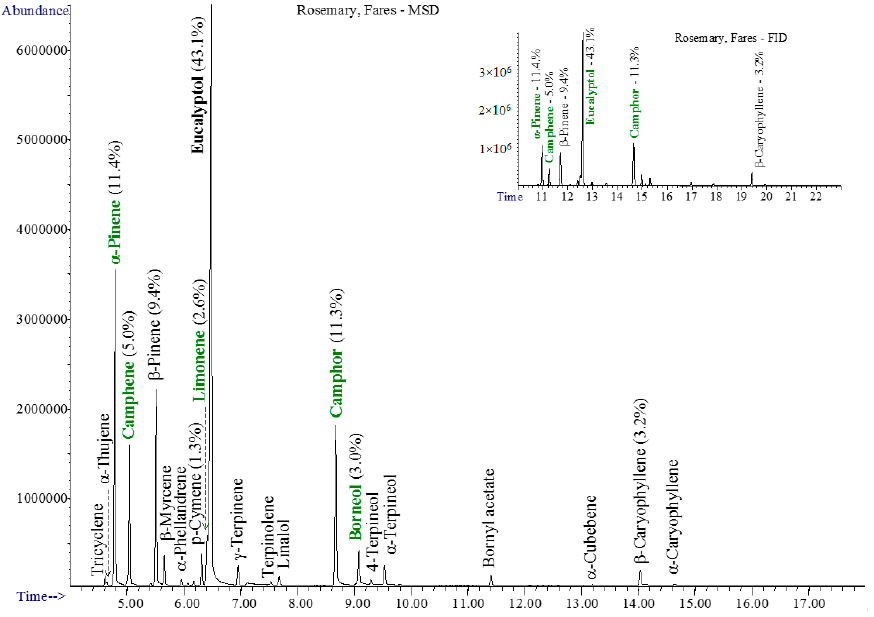
Figure 3. The GC-MSD and GC-FID (insert) chromatograms of rosemary oil.